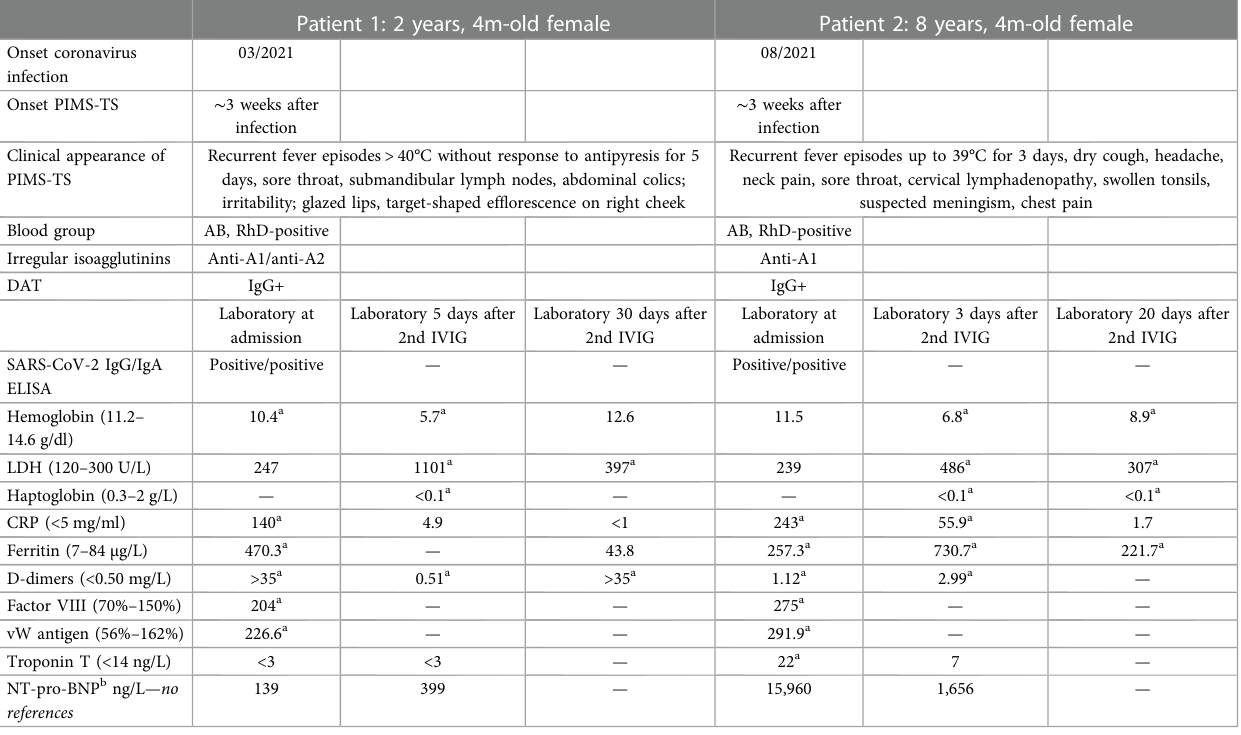
PIMS-TS, pediatric in fl ammatory multisystem syndrome temporally associated with SarsCov2; DAT, direct antiglobulin test; IVIG, intravenous immunoglobulin; CRP, C-reactive protein; LDH, lactate dehydrogenase. a Out of reference range. b Age-dependent reference range for